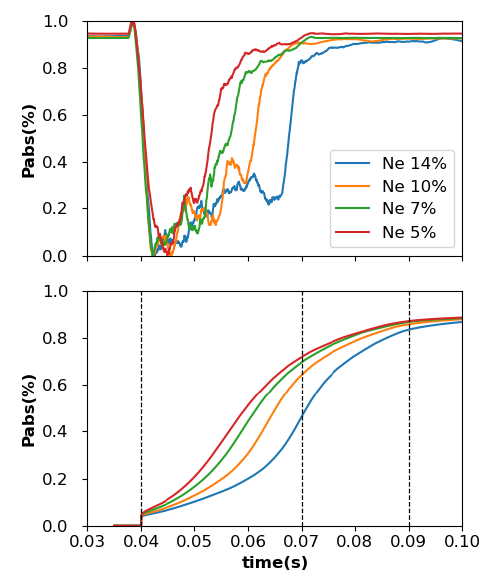
Figure 8. Comparison between absorption derived by sni ff er probe signals using the procedure described in section 3.2 (Top) and the absorption done with BKD0 and GRAY codes (Bottom) on #37949. The loop voltage measured is used as in-